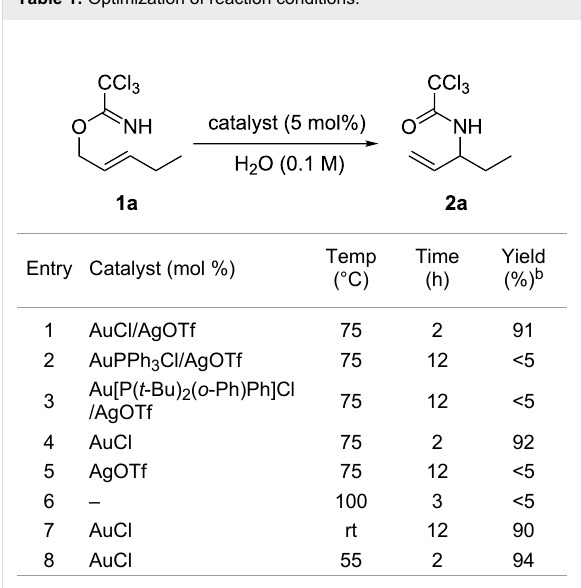
Table 1: Optimization of reaction conditions.